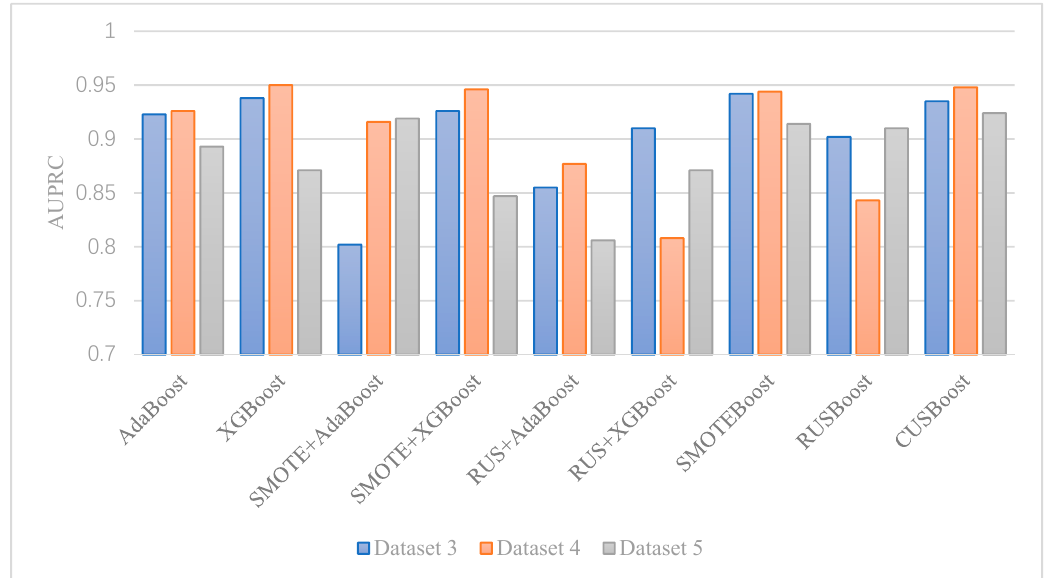
Figure 4. The impact of imbalance ratio on AdaBoost.